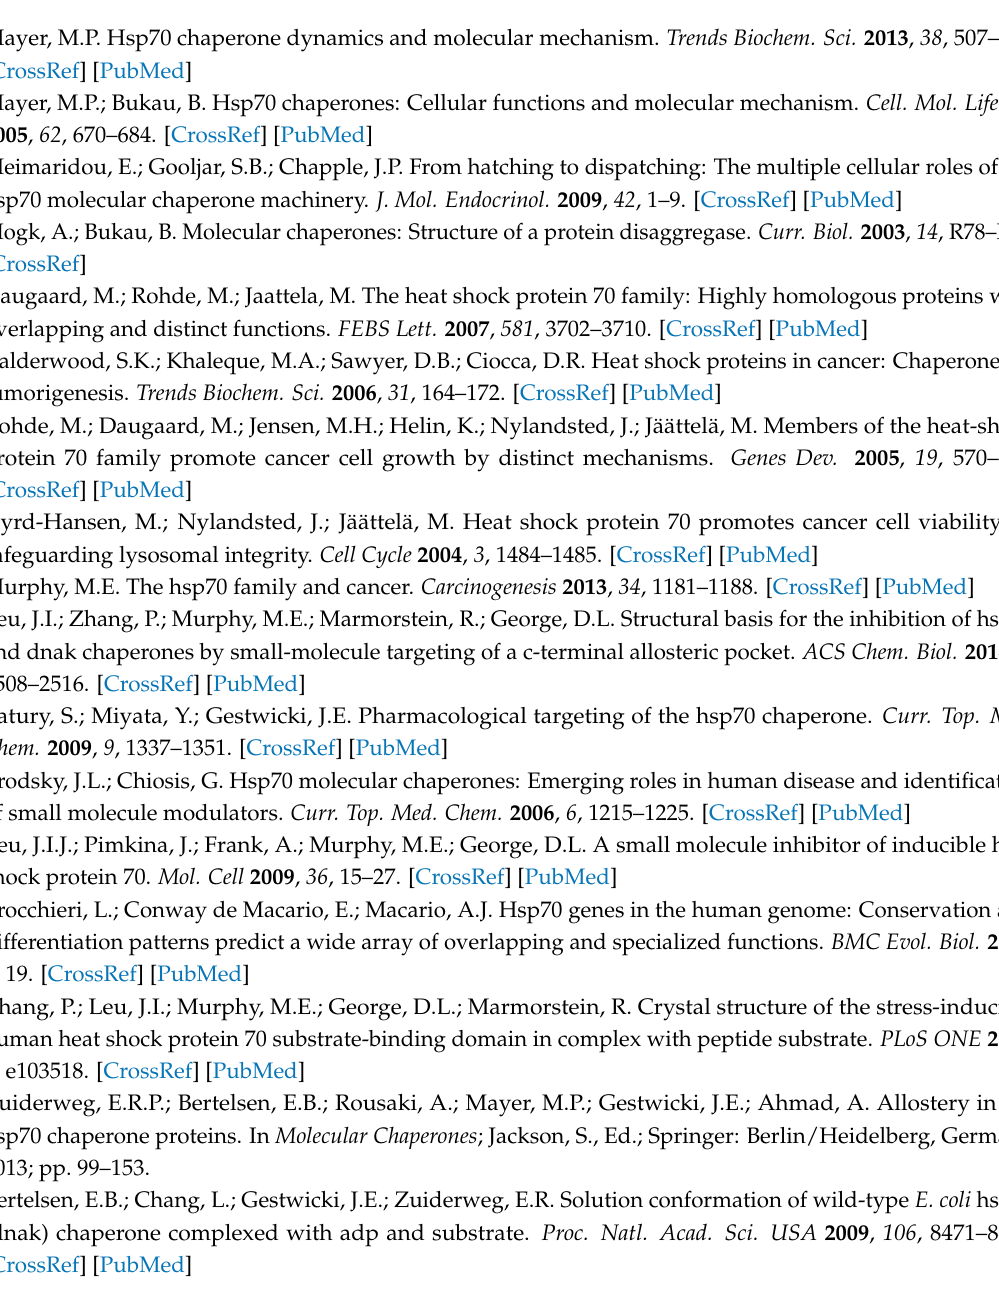
D529; Figure S11: Comparison of the positions of residues R447 and D529 engaged in the inter-subdomain interaction; Figure S12: Comparison of the positions of residues engaged in the interdomain contact between SBD and NBD; and Table S1: Structural statistics for the 10 lowest-energy structures of SBD( ∆ CDE) and SBD( ∆